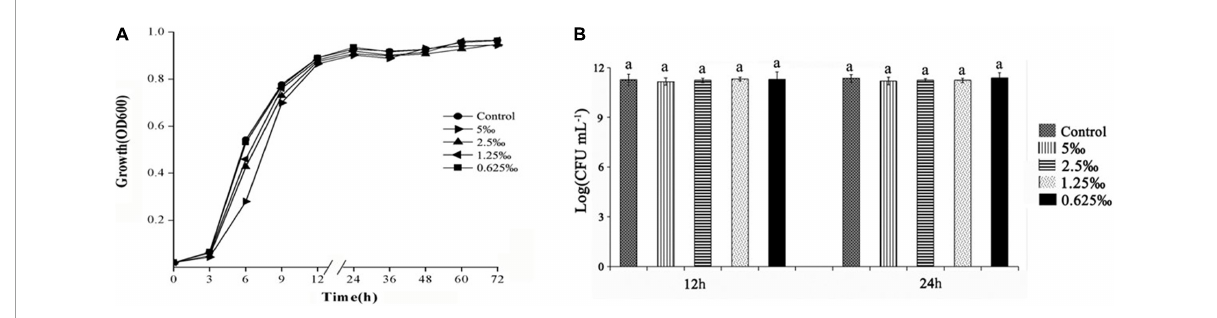
FIGURE1 Effect of methyleugenol (ME) on growth of Chomobacterium violaceum . Growth curves of C. violaceum treated with ME at the varying concentrations of sub-MIC (5, 2.5, 1.25, and 0.625